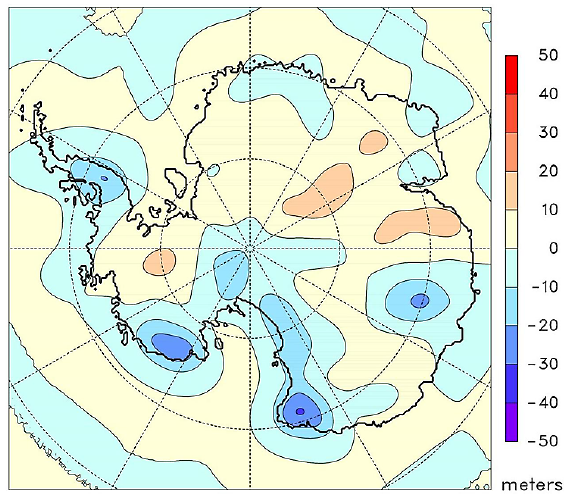
Fig. D1. Model minus observed modern bed elevations, meters, us- ing inverse method with sub-grid topographic influence, 20-km res- olution (as in Fig.